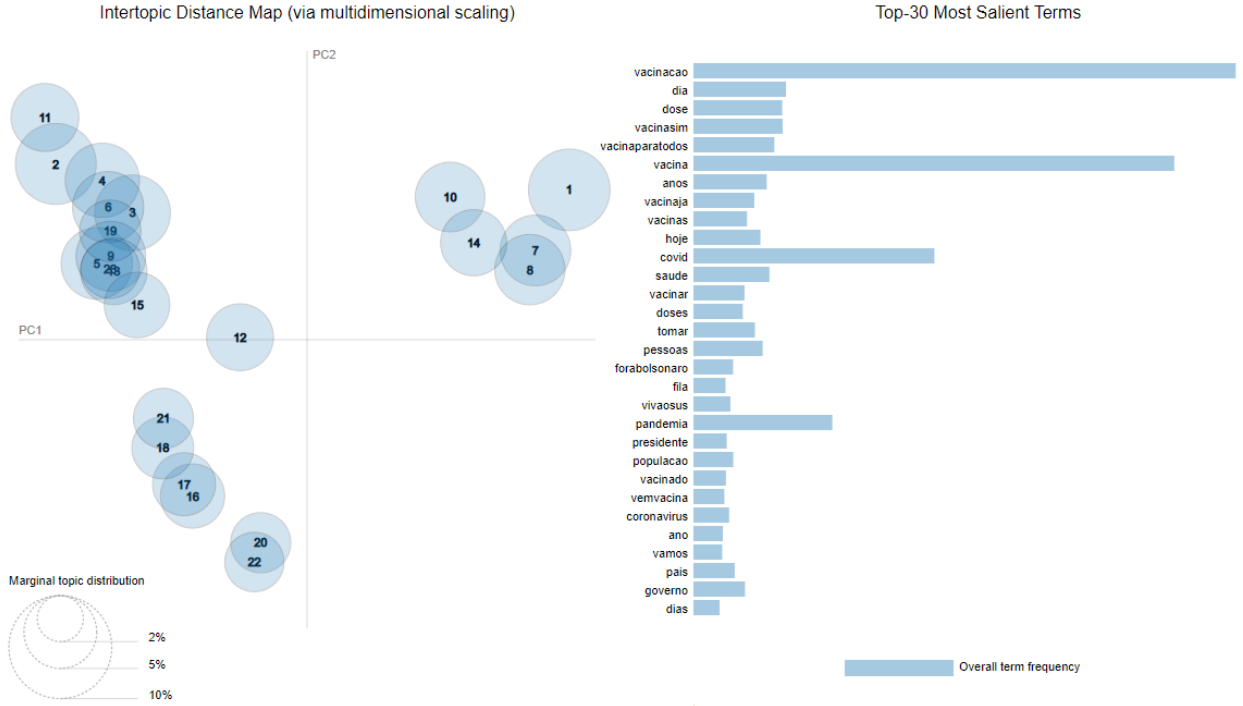
Figure 5. Intertopic distance map and the most salient terms found in the extraction process [45, 48].